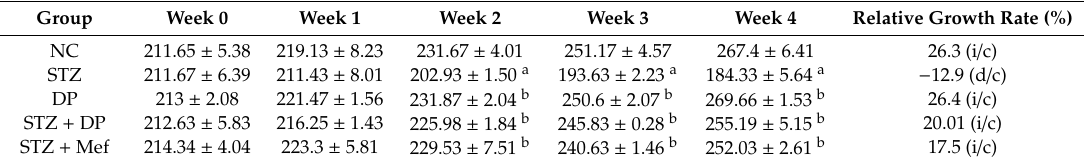
Table 2. E ff ect of Dendropanax (DP) on body weight in diabetic-induced nephrotoxicity rats after 28 days of